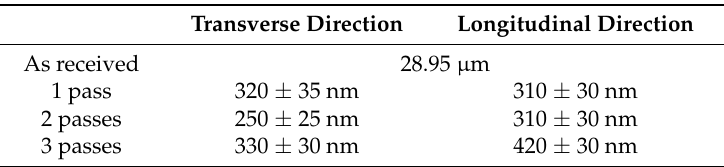
Figure 4. ( a ) Substructure in the transverse direction after the first pass; ( b ) substructure in the longitudinal direction after the first pass; ( c ) substructure in the transverse direction after the second pass; ( d ) substructure in the longitudinal direction after the second pass; ( e ) substructure in the transverse direction after the third pass; ( f ) substructure in the longitudinal direction after the third pass. Table 2. Mean grain size for different processing steps.